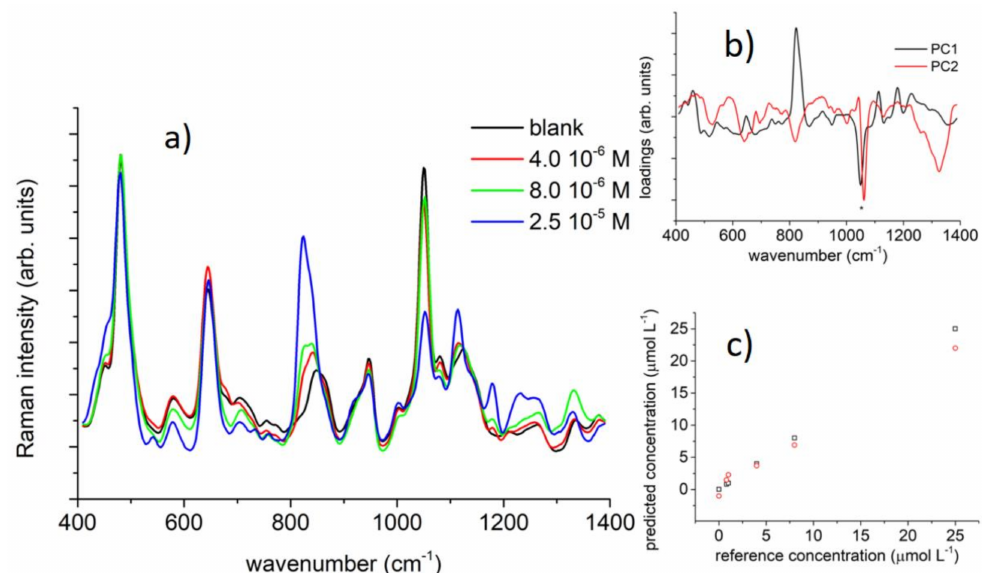
Figure 16. ( a ) BPA SERS spectra as a function of the BPA molar concentration. ( b ) Loadings for the first two components in the PCA analysis on the BPA SERS data. ( c ) Calibration curve as obtained by the partial least square regression analysis on SERS data. (Reprinted from [112] under Open Access